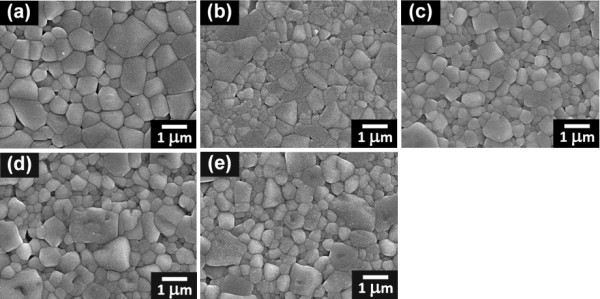
SEM micrographs of (1-x)BNKT-xBST ceramics. The samples were sintered at 1125°C. (a) x = 0, (b) x = 0.05, (c) x = 0.10, (d) x = 0.15, and (e) x = 0.20.